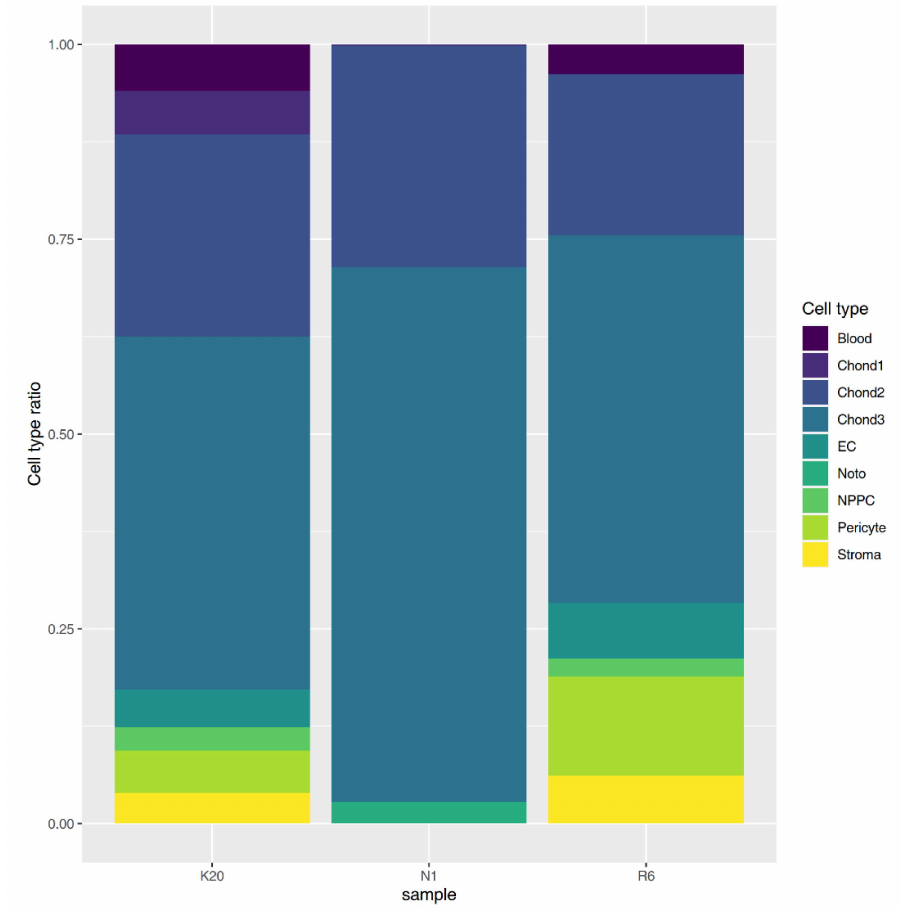
Figure 3. Intervertebral disc tissue transcriptome deconvolution by cell